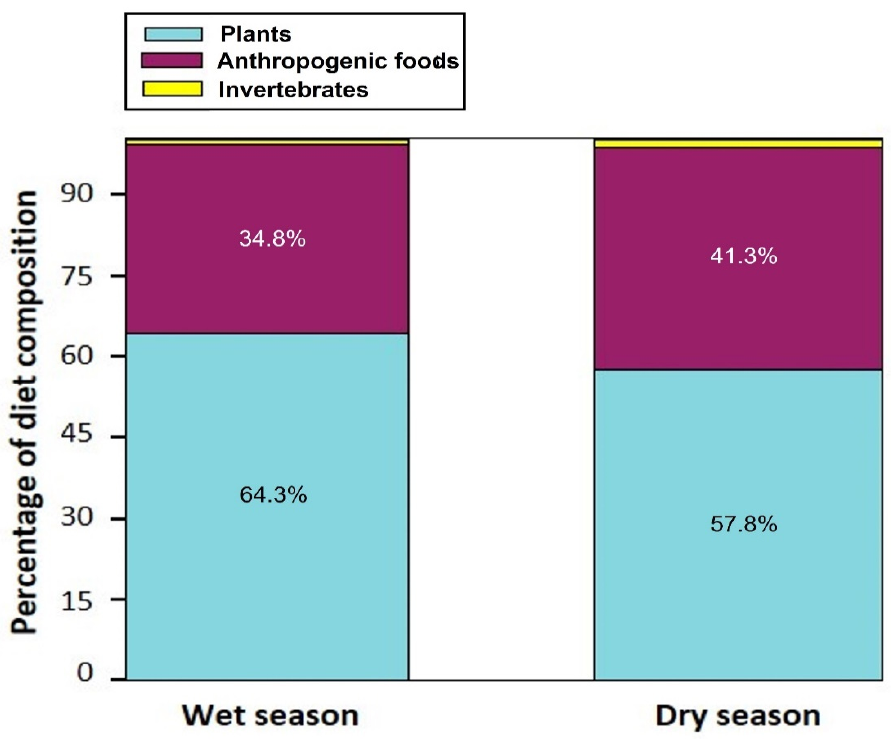
Figure 2. Proportion of daily activities spent by Lowe’s monkeys feeding ( p = 0.0001), moving ( p = 0.158), and resting ( p = 0.0001) during the dry and wet seasons in the Duasidan monkey sanctuary, Ghana ( xxx p < 0.001). The line in the boxes represents a median value while the boxes represent interquartile ranges and whiskers represent the range of minimum and maximum values.